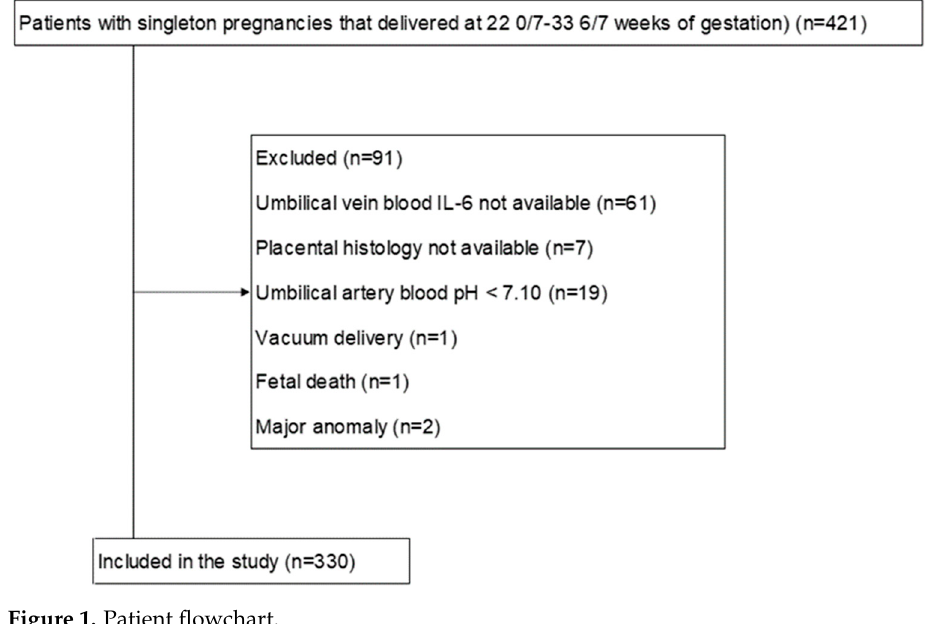
Figure 1. Patient flowchart.